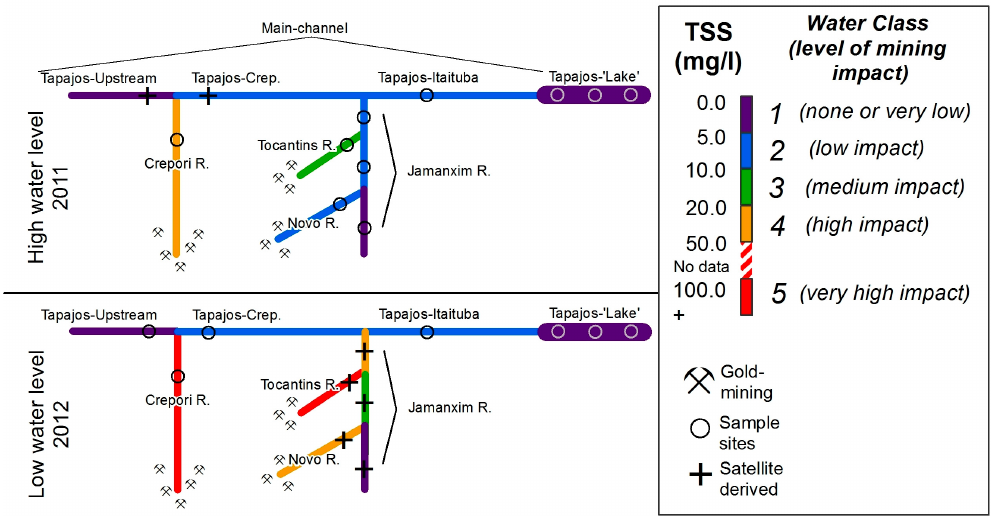
Figure 3. Schematic representation of TSS concentrations along the Tapajós River and its tributaries for high (April 2011) and low (September 2012) water levels. The river and its tributaries were classified according to TSS (mg·L − 1 ) concentrations. TSS for Tocantins, Novo, and Jamanxim rivers during the low water season were retrieved from Landsat surface reflectance (red band) [51]. The level of mining impact is an arbitrary classification considering the intensity level of mining and mining area distribution. Not to scale.